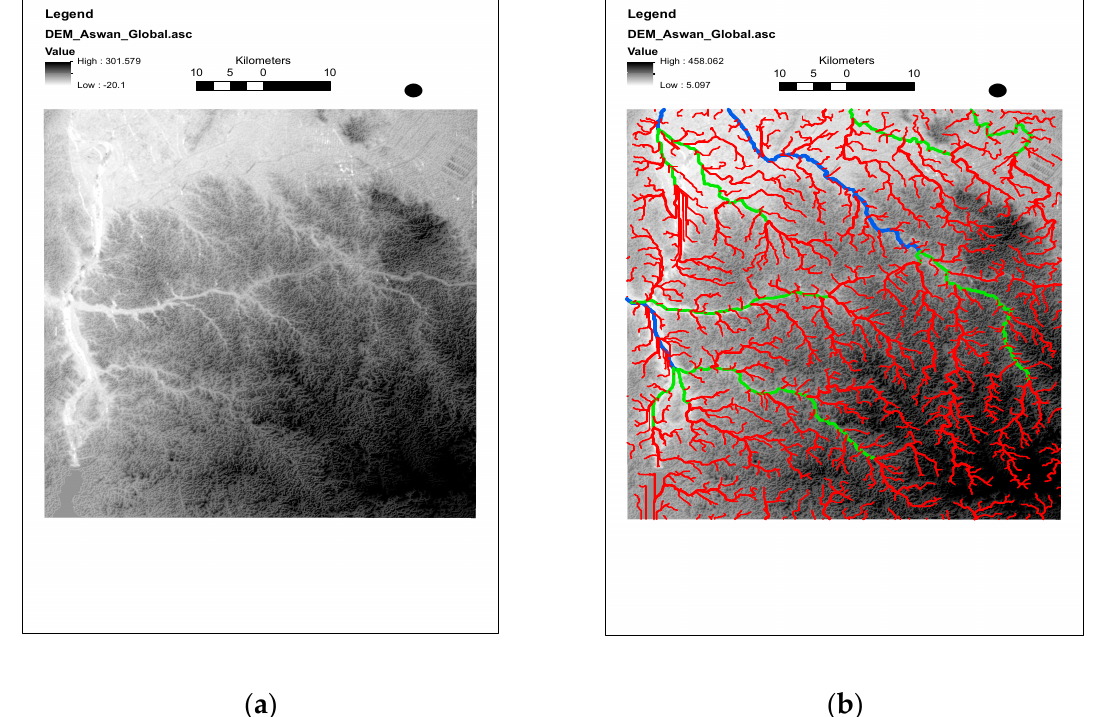
Figure 4. Digital elevation model (DEM) file and water streams. ( a ) Study area DEM file; ( b ) Study area water streams network.